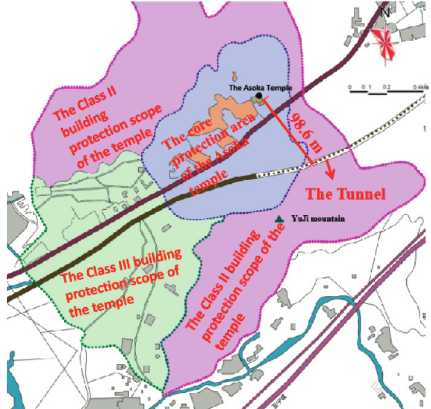
Figure 8: The location map of the Asoka